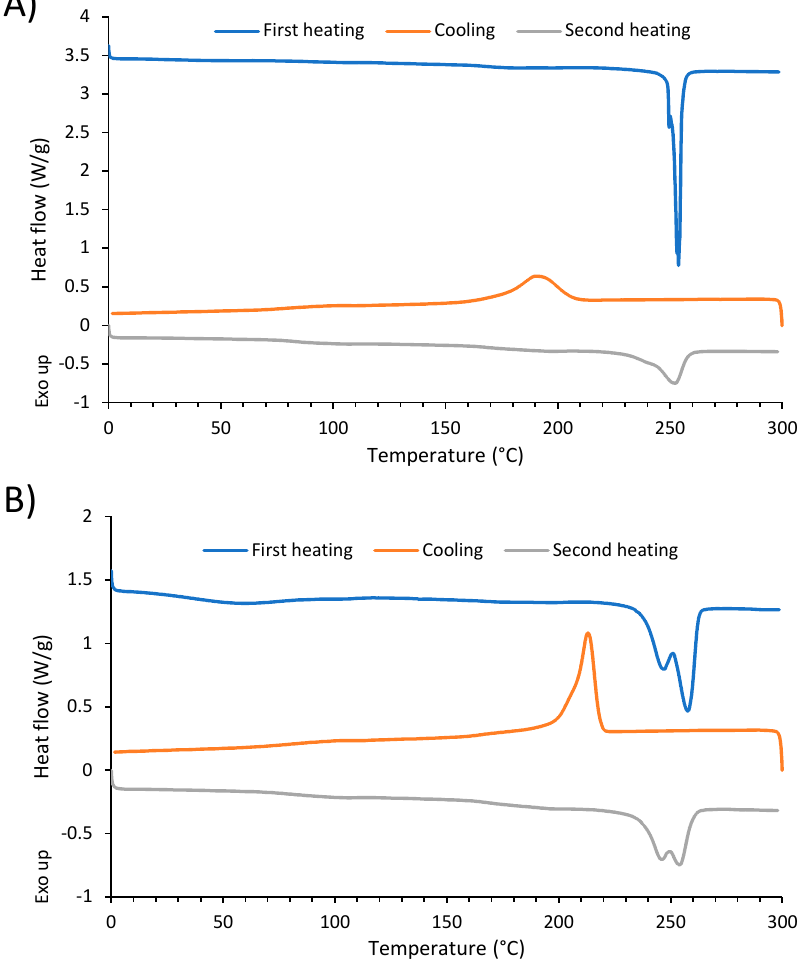
Figure 11. DSC curves of ( A ) virgin PET and ( B ) recycled PET.